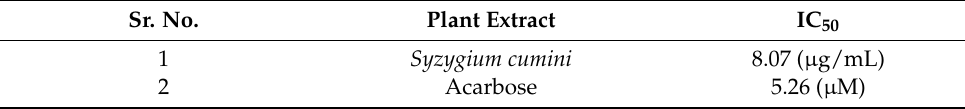
Table 1. Tabular depiction of IC 50 of Syzygium cumini extract. Sr.